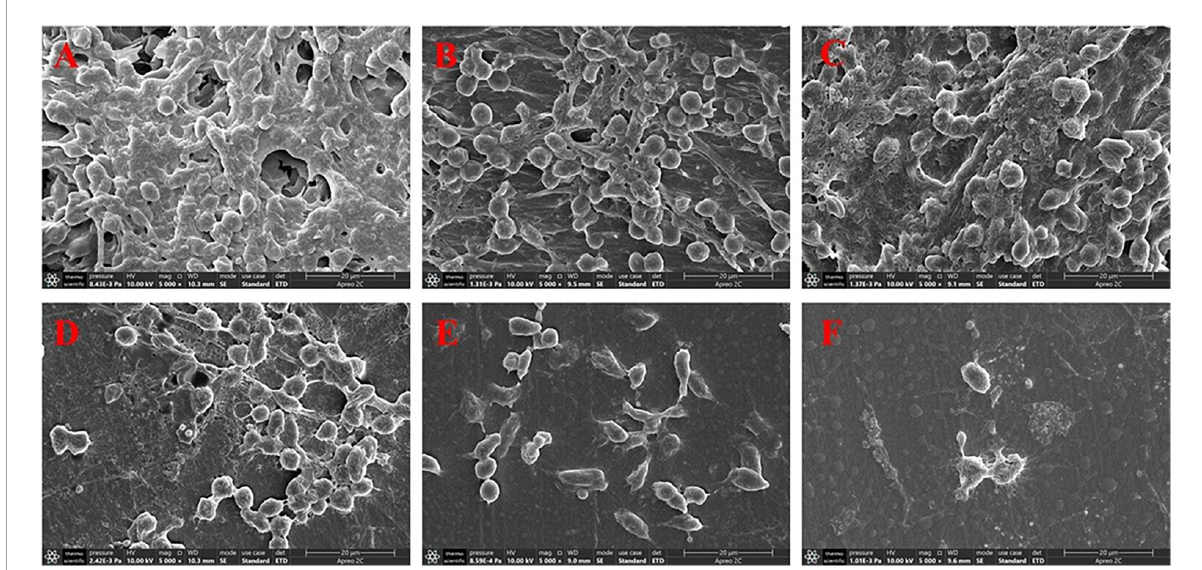
FIGURE7 Scanning electron microscopy images at 5,000 × magnification of biofilms in peritoneal implants from mice. The doses of the drug were (A) physiological saline, (B) 40 mg/kg geraniol, (C) 40 mg/kg vancomycin, (D) 10 mg/kg geraniol + 40 mg/kg vancomycin, (E) 20 mg/kg geraniol + 40 mg/kg vancomycin, and (F) 40 mg/kg geraniol + 40 mg/kg